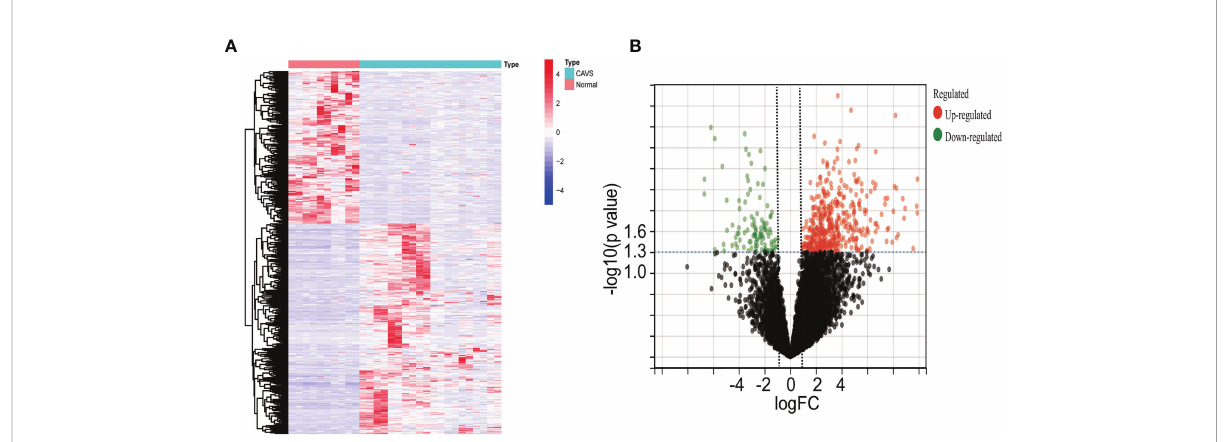
FIGURE 2 Differential gene analysis of GSE51472 and GSE153555 datasets. (A) Heatmap of the combined GEO database. Green represents downregulated genes, and red represents upregulated genes. (B) Volcano plot of the combined GEO database. Left green plots represent genes that are